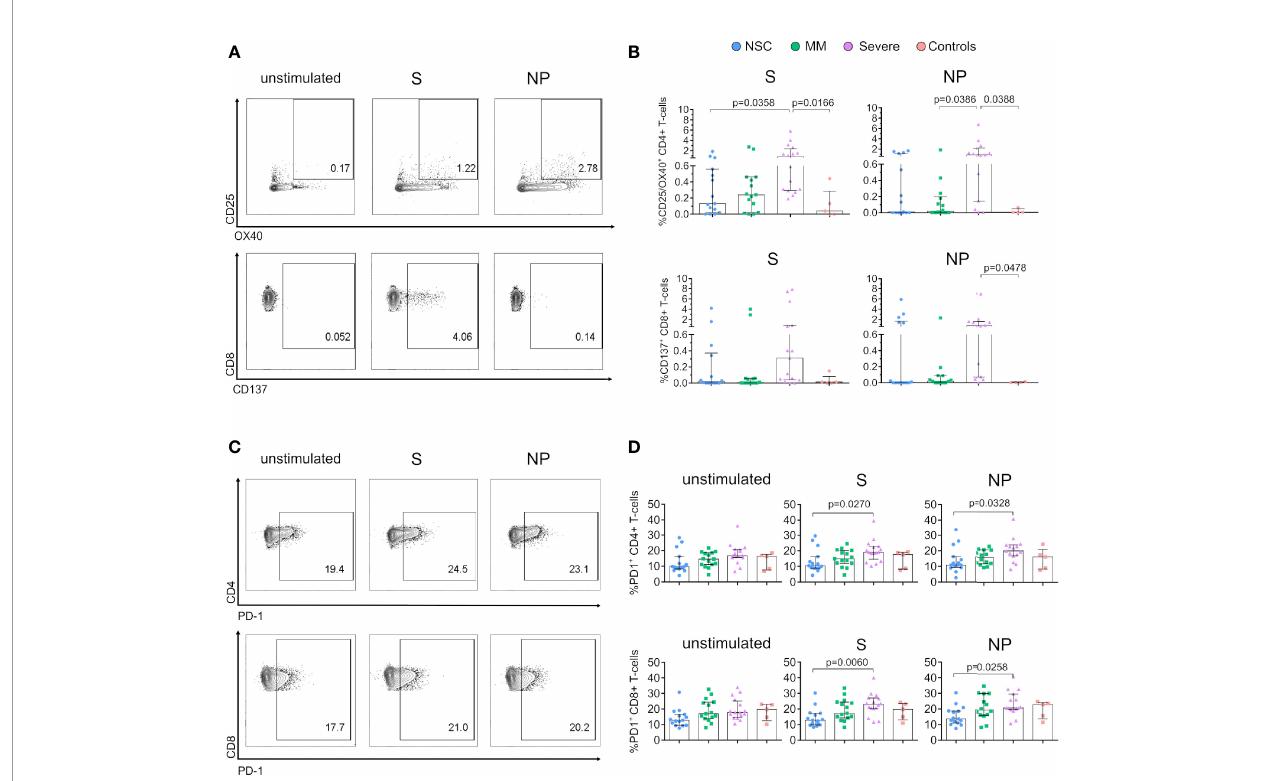
FIGURE 2 | Expression of activation markers is lower in SARS-CoV-2 Non-Seroconvertors compared to seropositive individuals. PBMCs from Non-Seroconvertors and comparative study groups were stimulated for 17 hours with S and NP recombinant proteins and stained using antibodies directed against activation-induced markers (AIM; CD25, OX40, CD137) and PD-1, and analysed by fl ow cytometric analysis. Cells were pre-gated for lymphocytes and live cells. (A) Representative dot-plots of AIM expression in CD4+ and CD8+ T cells. (B) Bar graphs showing the expression of activation induced markers in CD4+ (CD25 + /OX40 + ) and CD8+ T cells in response to S and NP (CD137 + ). Values from unstimulated cells were subtracted for each individual. (C) Representative dot-plots of PD-1 expression on CD4+ and CD8+ T cells. (D) Bar graphs of the expression of PD-1 on CD4+ and CD8+ T cells in unstimulated cells as well as following S and NP stimulation. Error bars represent the interquartile range and median values per group are shown. Statistical analysis was performed using Kruskal-Wallis non-parametric ANOVA adjusted for multiple comparisons, only signi fi cant differences are highlighted in the